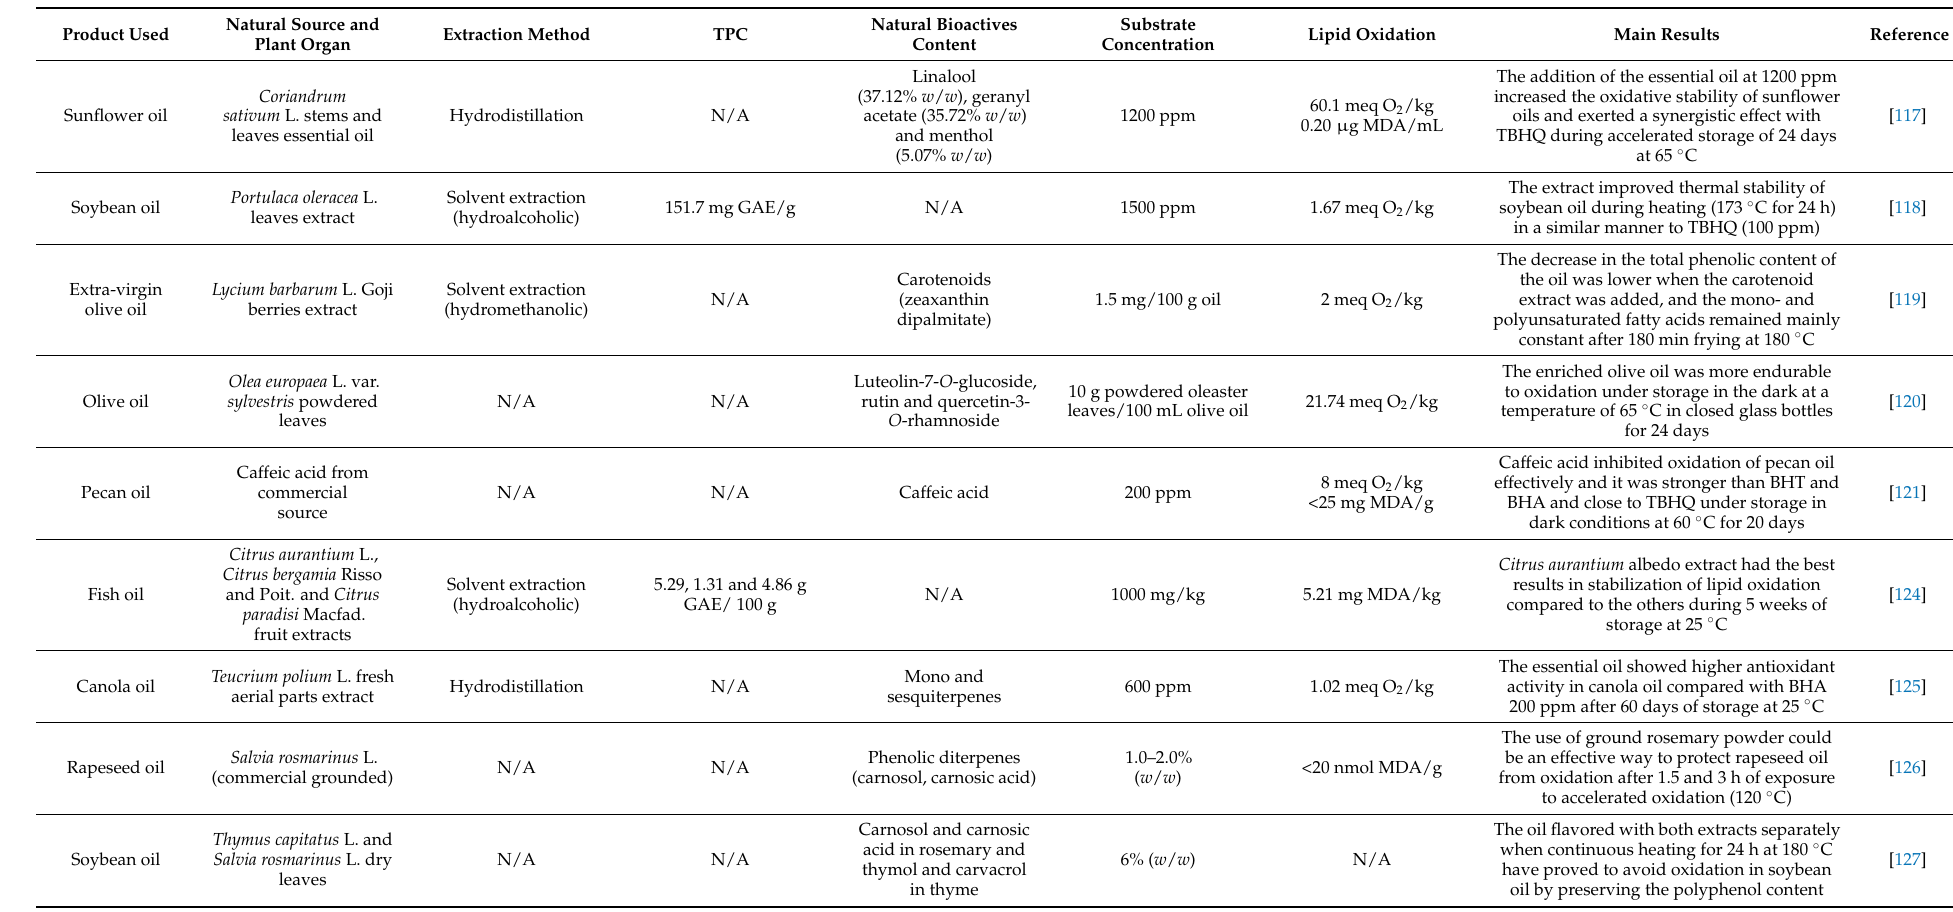
Table 3. Effect of natural antioxidants on lipid stability of oil food matrices. MDA: malondialdehyde; N/A: not available; GAE: gallic acid equivalent; meq: milliequivalents; TPC: total phenolic